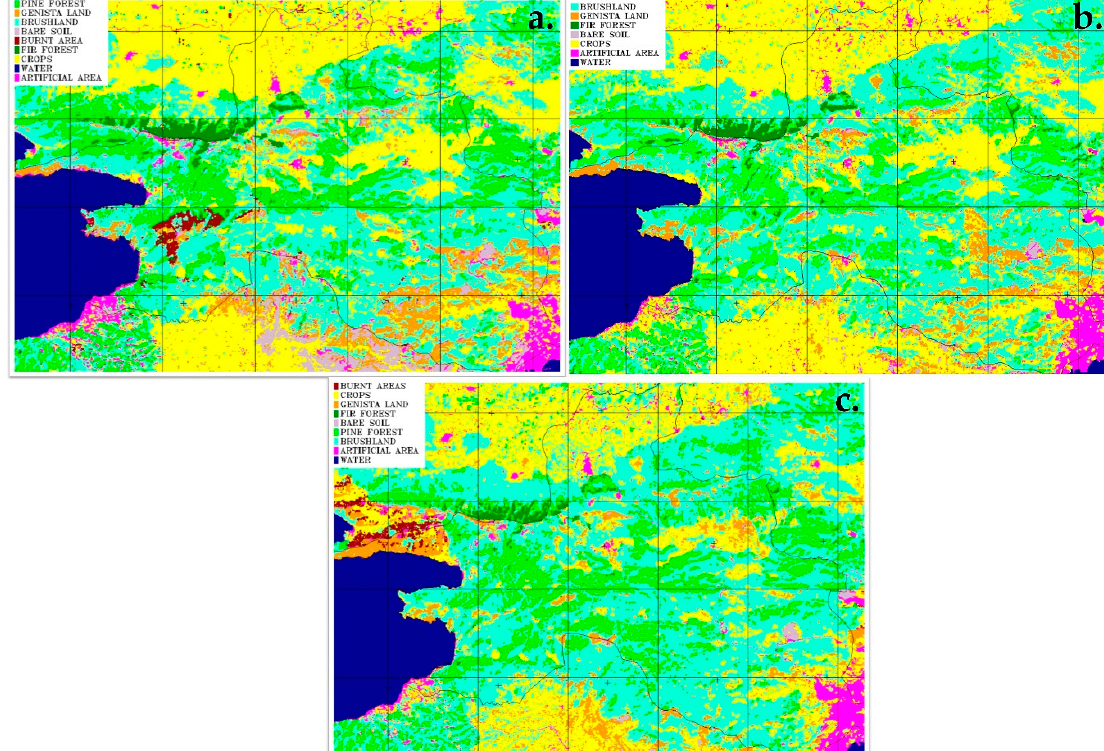
Figure 5. Map products by SVMs classification, ( a ) 1993, ( b ) 2001 and( c ) 2010.